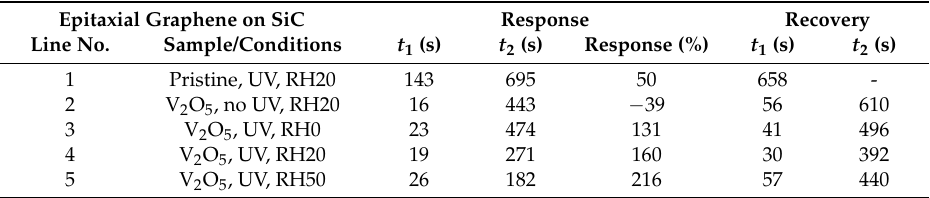
Table 2. Bi-exponential fitting parameters of functionalised epitaxial graphene sensor response and recovery curves at 8 ppm NH 3 , shown in Figures 4 and 5, with Equation (1). The coefficients t 1 and t 2 are time constants in exponential functions. Response amplitude ( A 1 + A 2 )/ G 0 is shown in %. RH stands for relative